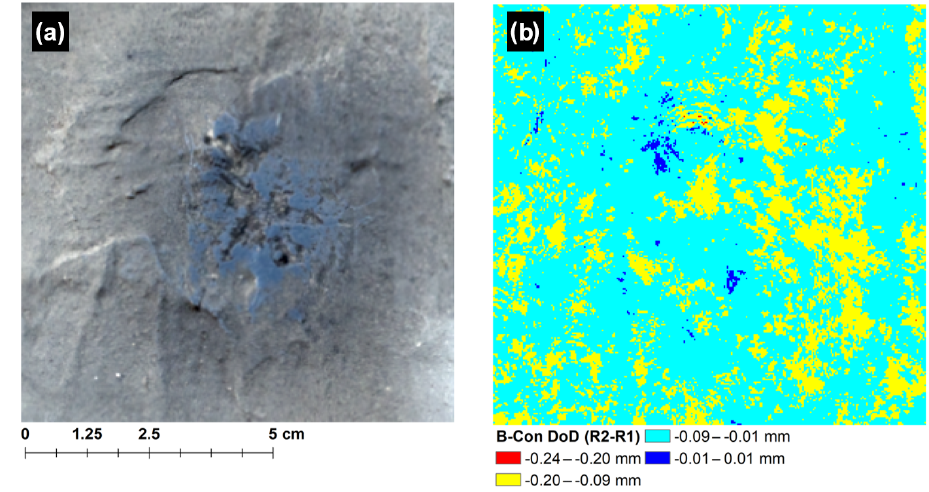
Figure 2. (a) The control block (B-Con) orthophoto and (b) DoD showing a change in surface elevation between successive DEMs. Note that detected change is within the calculated LoD ( ± 0 . 27mm).